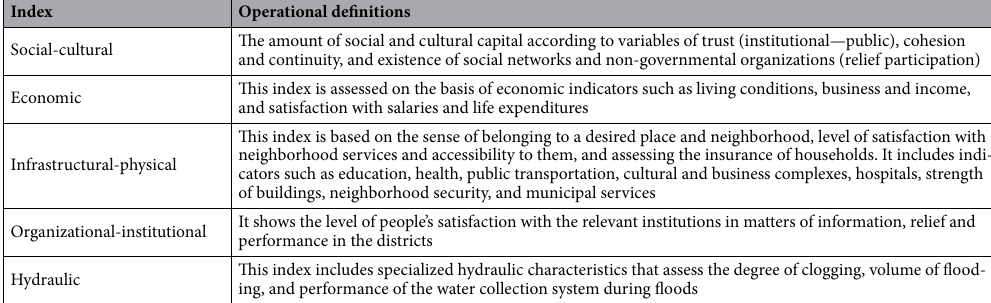
Table 1. Various resilience indices with their quick